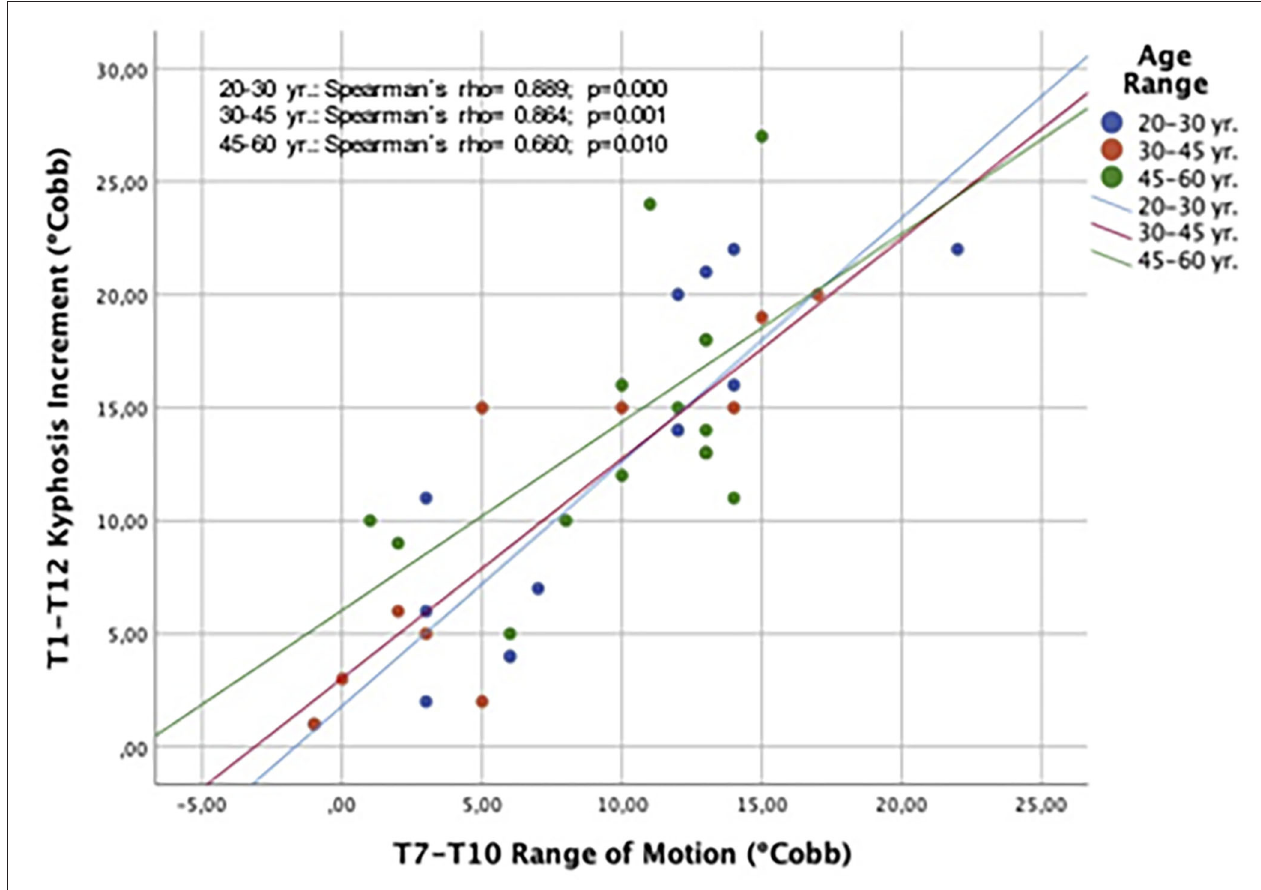
FIGURE 6 | Spearman’s correlation plot showing the relationship between changes in T7–T10 ROM and the global T1–T12 kyphosis during forced respiratory movements. Results are discriminated by age ranges.